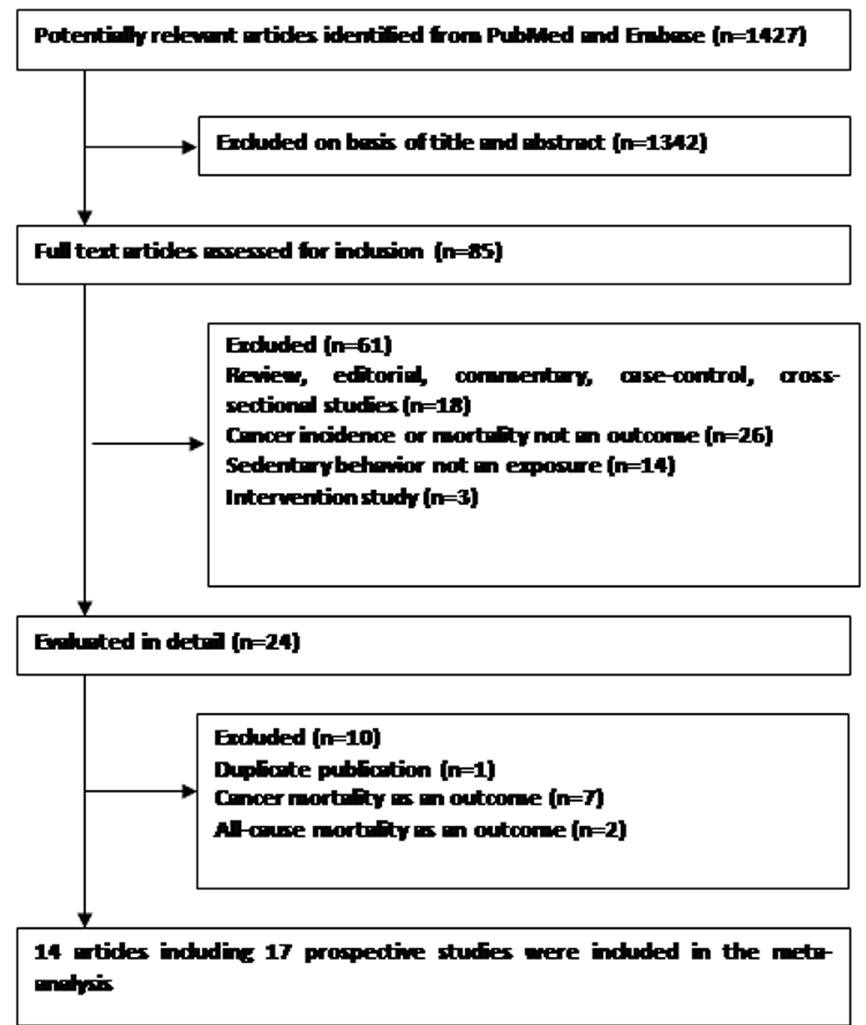
Figure 1. Flow diagram of literature search and study selection.